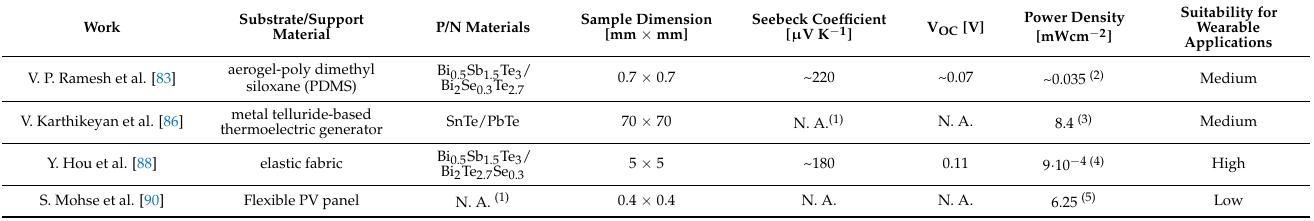
Table 5. Comparative table of thermoelectric (TEG) wearable-based energy harvesters.